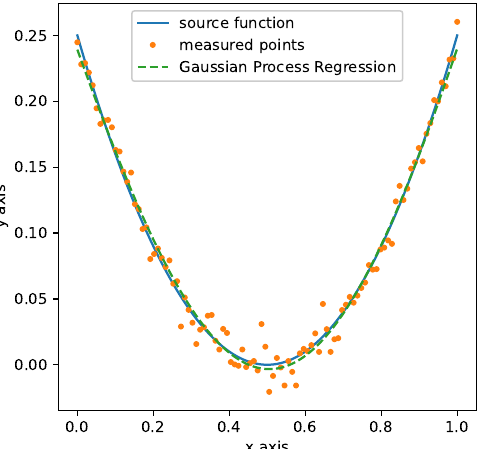
Figure 2. Source function from Equation (12), as well as generated data and GPR